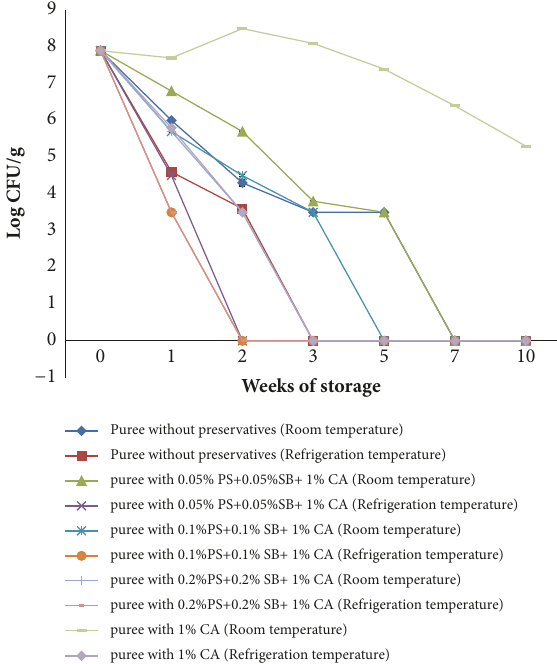
Figure 6: Microbial counts of yeast and molds in OFSP puree with and without preservatives during storage at ambient temperatures (15- 25 ∘ C) and refrigeration temperature (4 ∘ C). PS : potassium sorbate, SB : sodium benzoate, and CA : citric